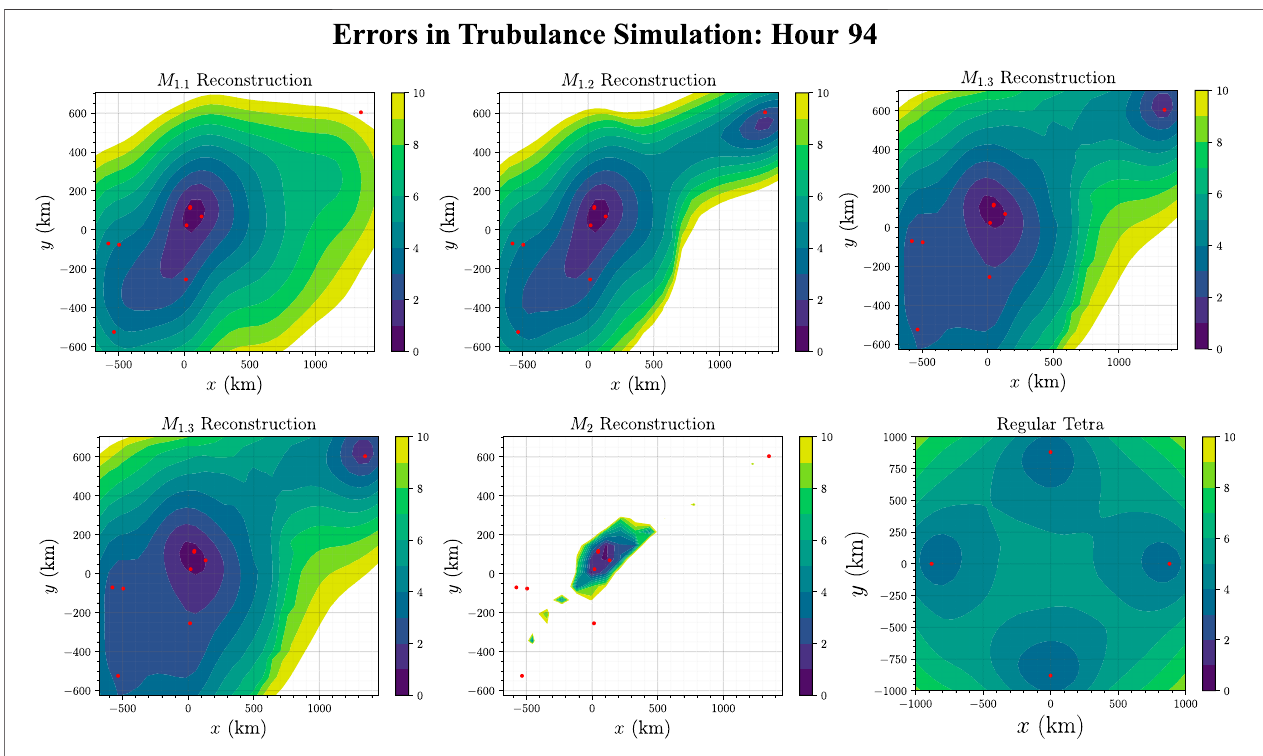
FIGURE 8 | Computation error (de fi ned in Eq. 7 ) at all points on the z (cid:1) 0 plane of the turbulent magnetic fi eld (from the Gkeyll Simulation), using the swarm con fi guration at hour 94 of the HelioSwarm DRM. The layout is identical to Figure 4 .